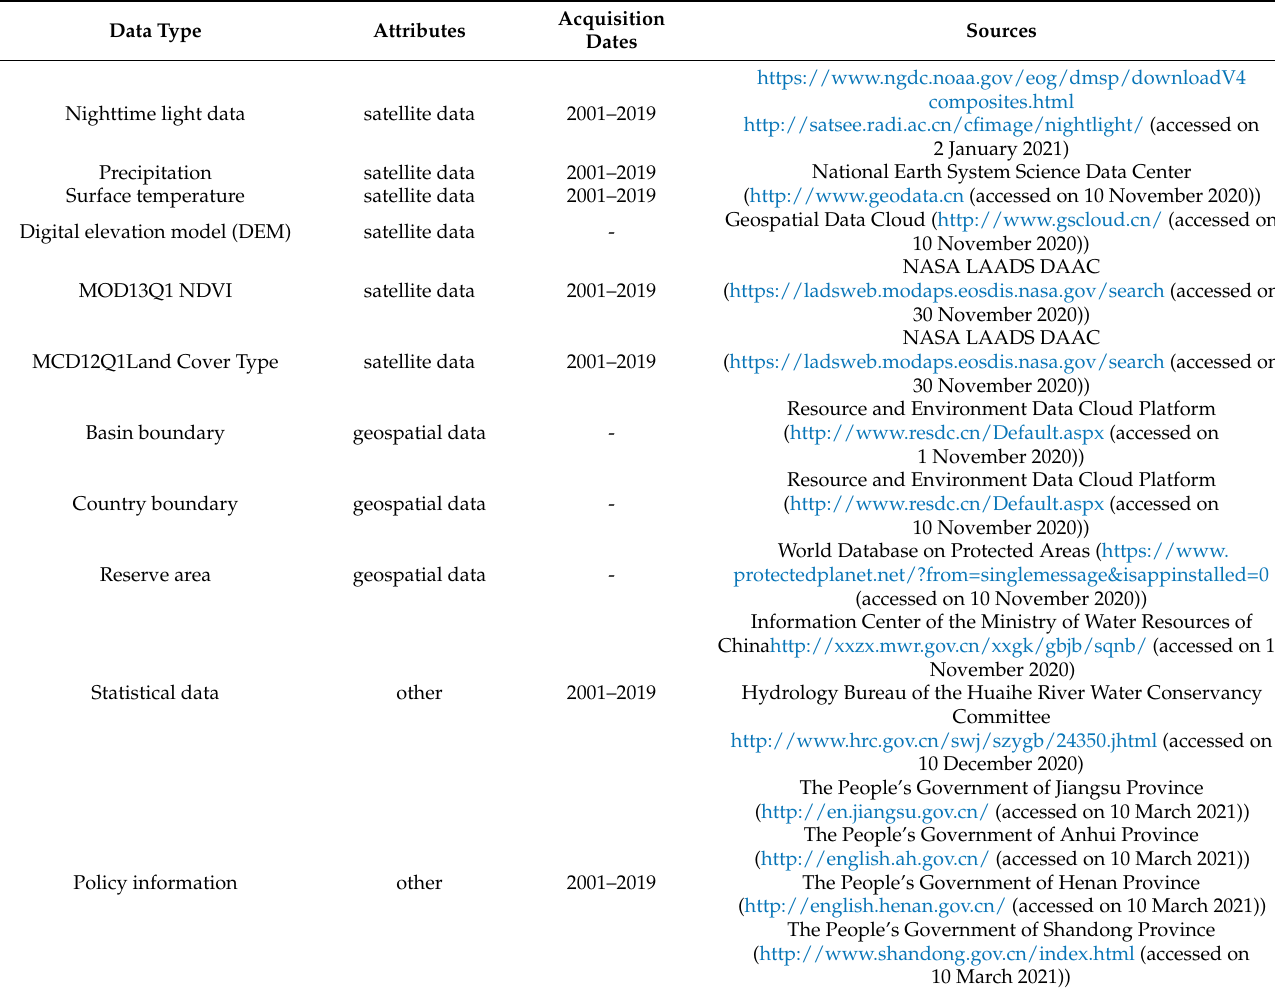
Table 3. Data source